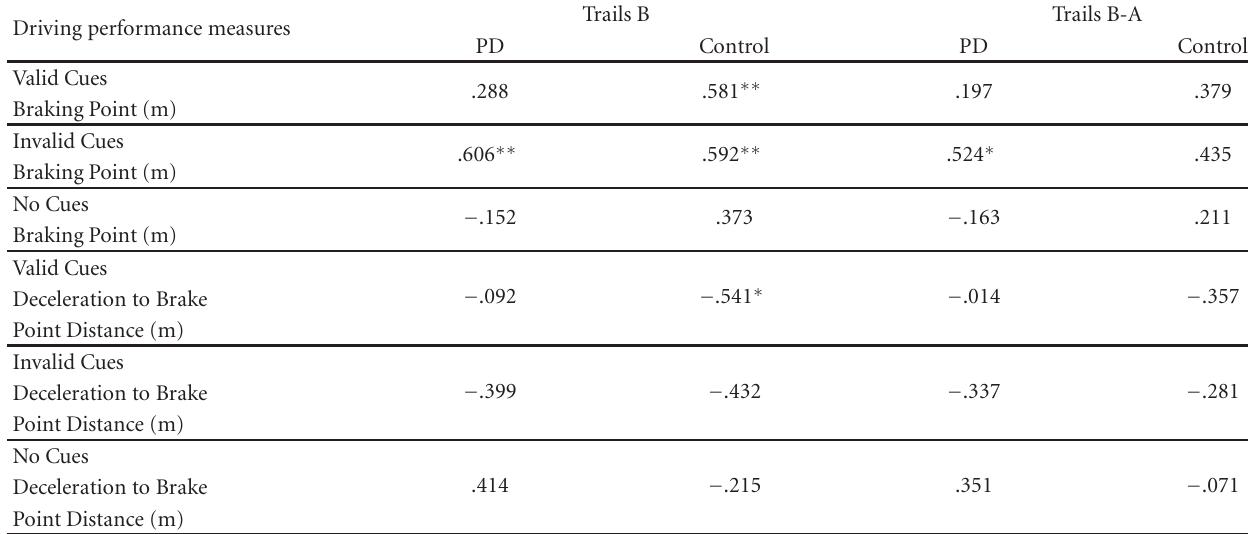
Table 3: Correlations between driving performance variables and Trail Making Test scores (part B and